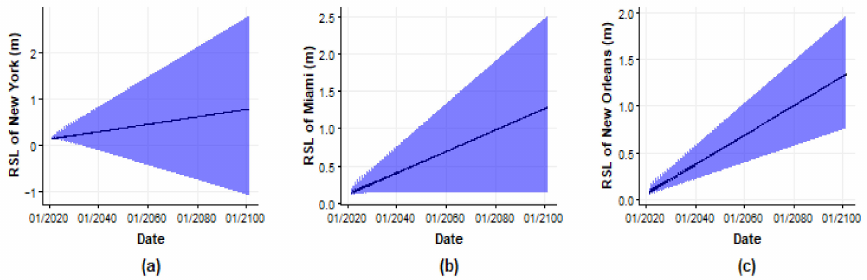
Figure 10. The blue area represents the prediction intervals. ( a ) Predicted regional sea levels of New York City; ( b ) Miami and ( c ) New Orleans over the next 80 years.